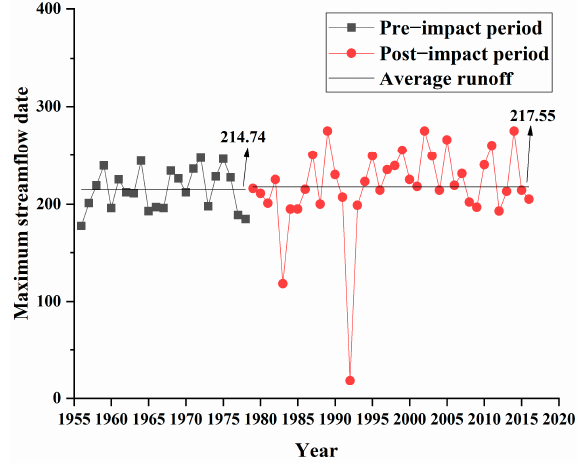
Figure 11. Maximum streamflow date.